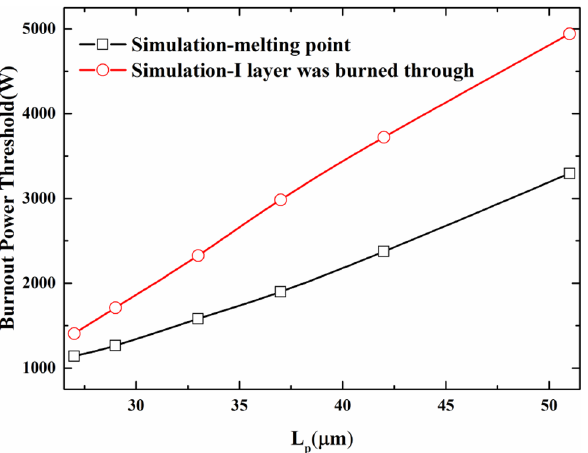
Figure 9. Simulation results of the relationship between the anode diameter of the PIN diode and the burnout power